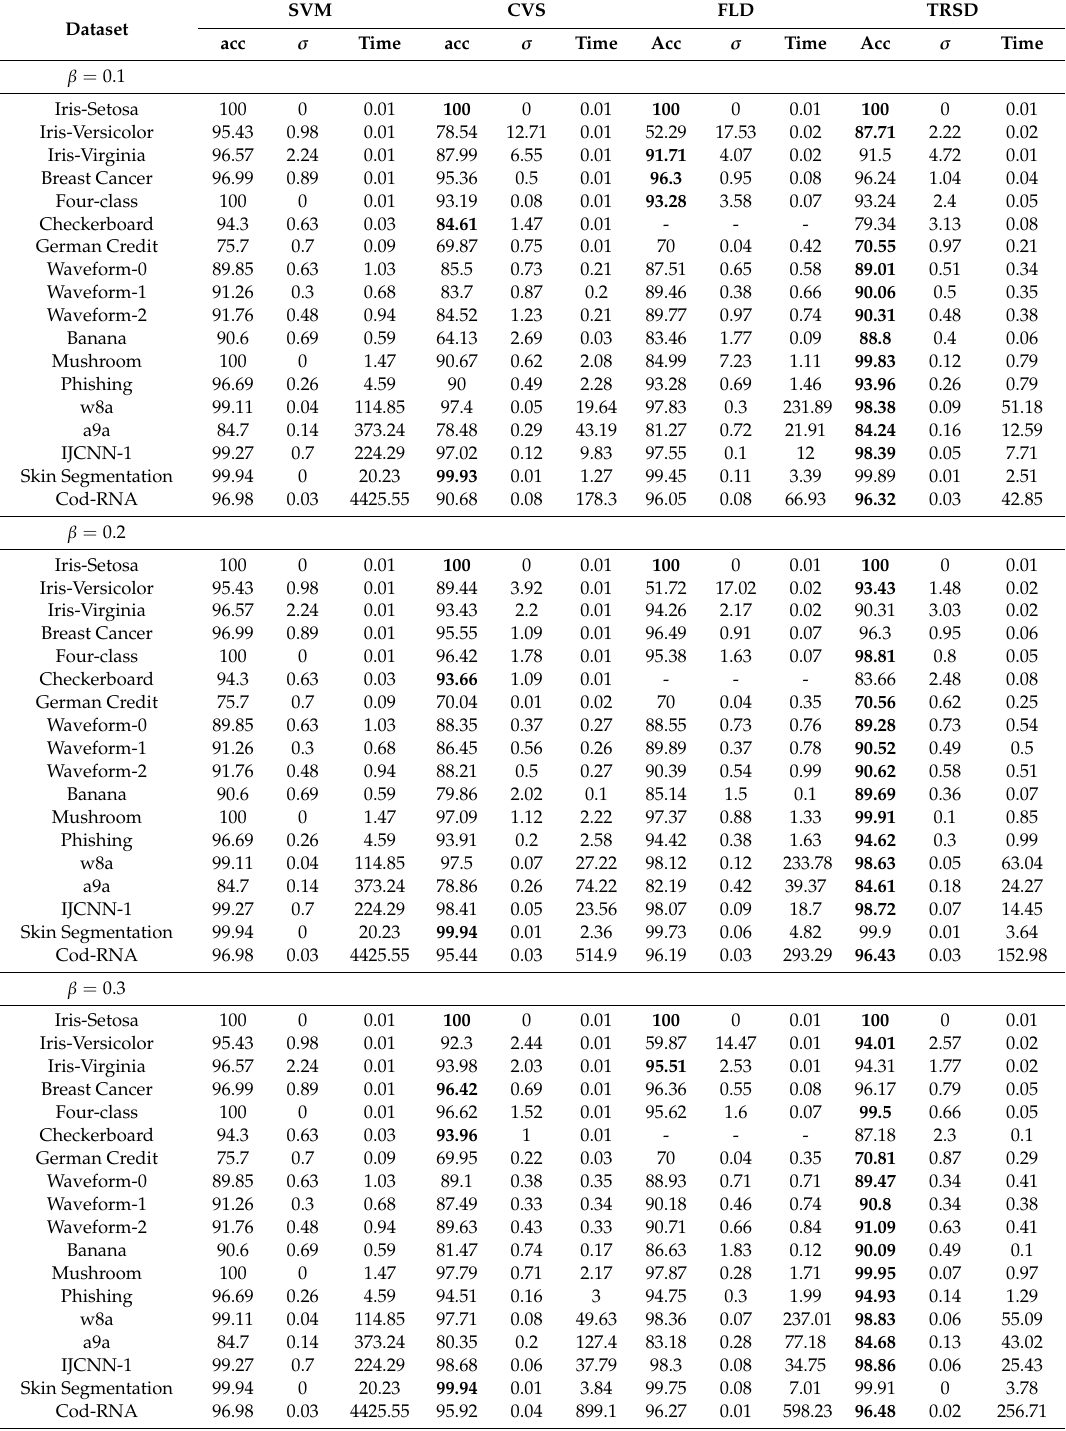
Table 4. Comparisons in terms of accuracy and time on datasets (the results of support vector machines (SVM) are not bolded, because it had access to all